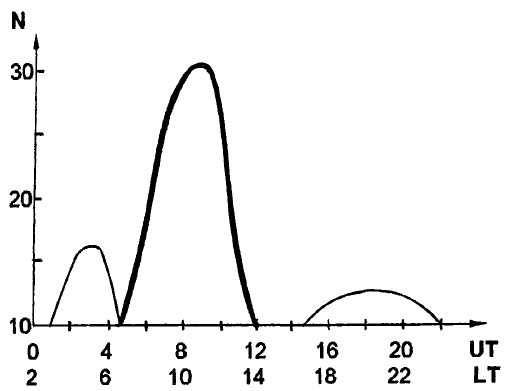
Fig. 5. The diurnal variation of the occurrence of Pc1s with decreasing central frequency ( bold line ) and with increasing frequency ( thin line )